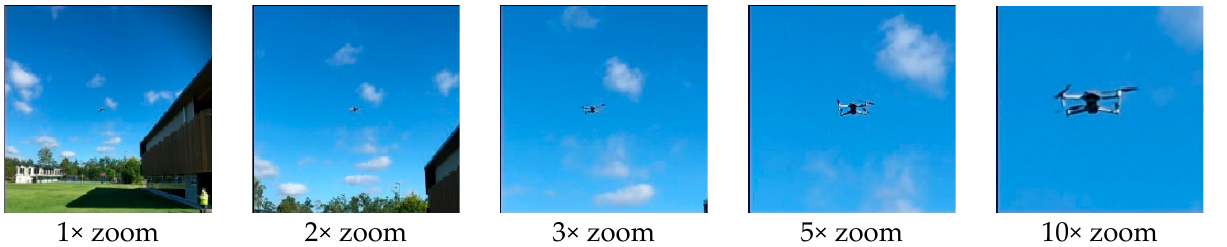
Figure 3. Effect of Different Camera Zoom Levels On Size and Image Background (UAV: DJI Mavic Air, h = 5 m, d = 10 m, images reduced to 256 × 256 resolution).